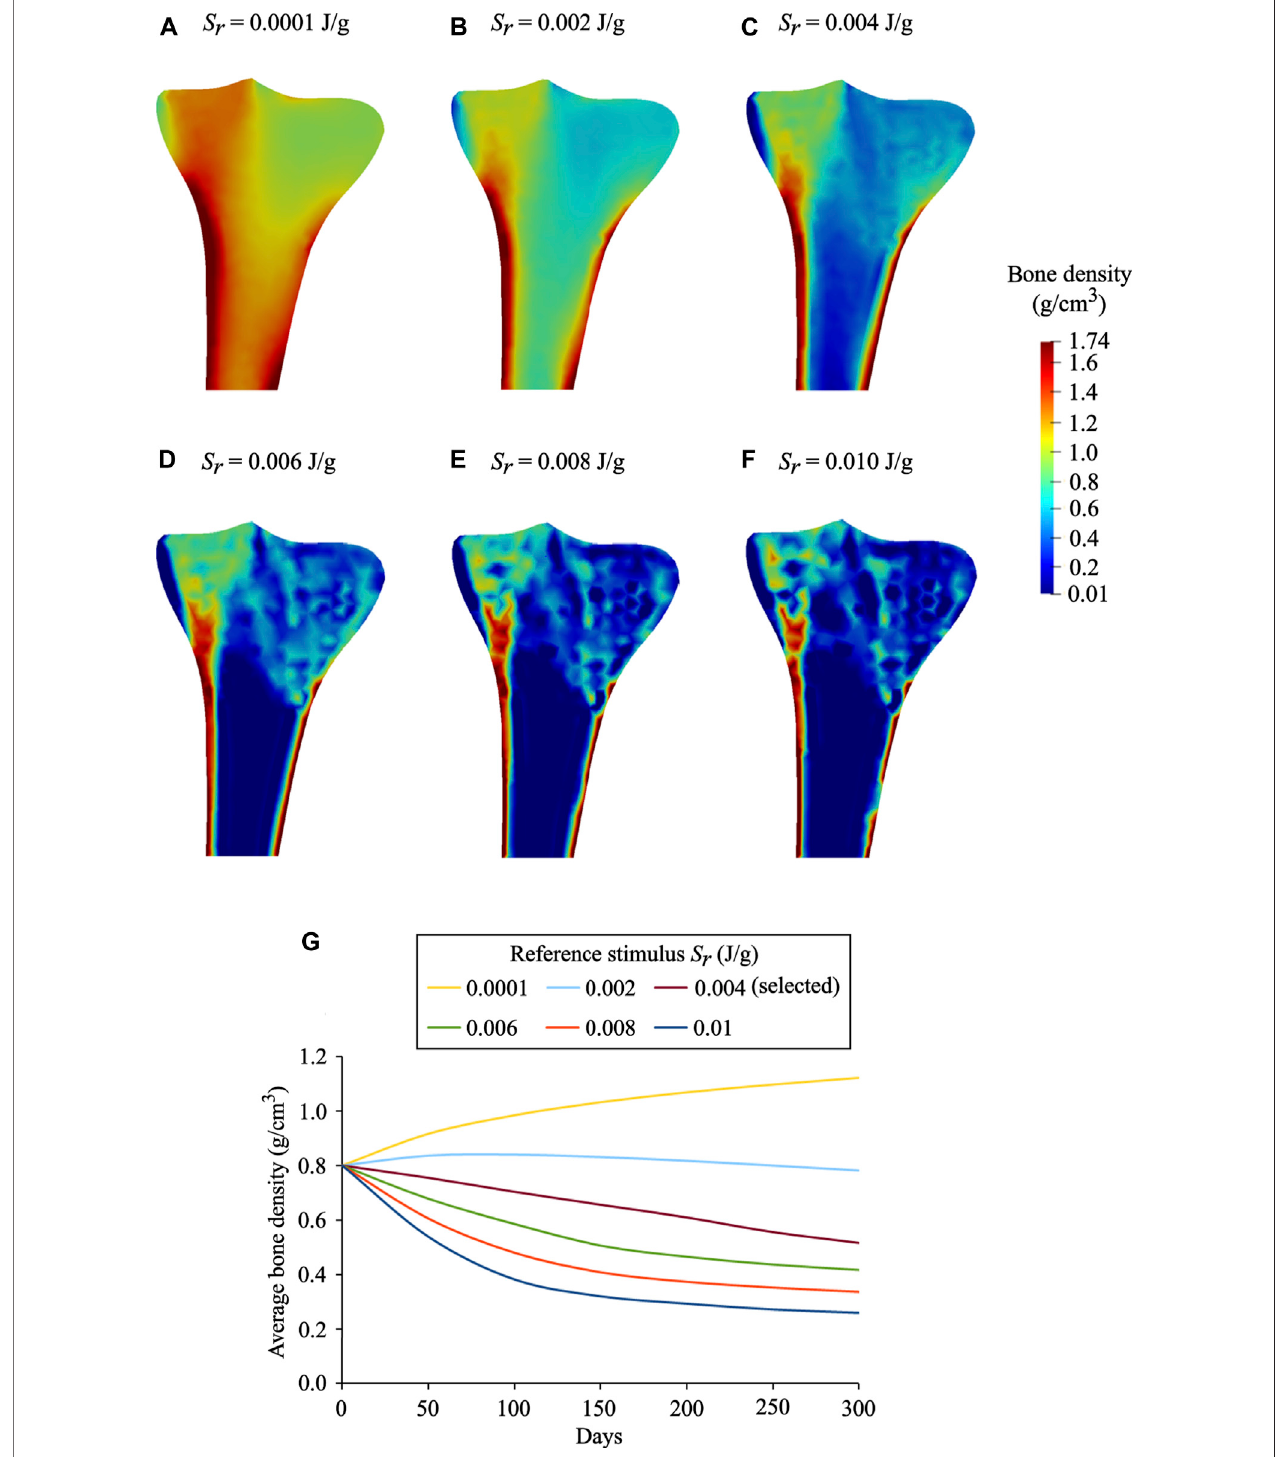
FIGURE 9 | Final bone density distributions ( t (cid:1) 300 days) obtained for distinct values of reference stimulus: (A) S r (cid:1) 0.0001 J/g, (B) S r (cid:1) 0.002 J/g (C) S r (cid:1) 0.004 J/g(selected), (D) S r (cid:1) 0.006 J/g (E) S r (cid:1) 0.008 J/g,and (F) S r (cid:1) 0.010 J/g. (G) Evolutionofaveragebonedensityobtainedforthereferencestimulusvaluesrangingfrom 0.0001 J/g to 0.01 J/g.